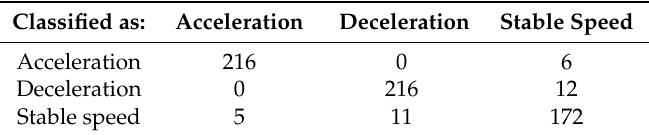
Figure 9. Accuracy obtained using shapelets. Features sorted according to the decreasing accuracy of shapelet trees. Dark-green bars represent accuracy for single trees, light-green bars represent the accuracy of the forest, created by adding trees one by one. Graph obtained for the left channel data. Table 4. Confusion matrix for the ensemble